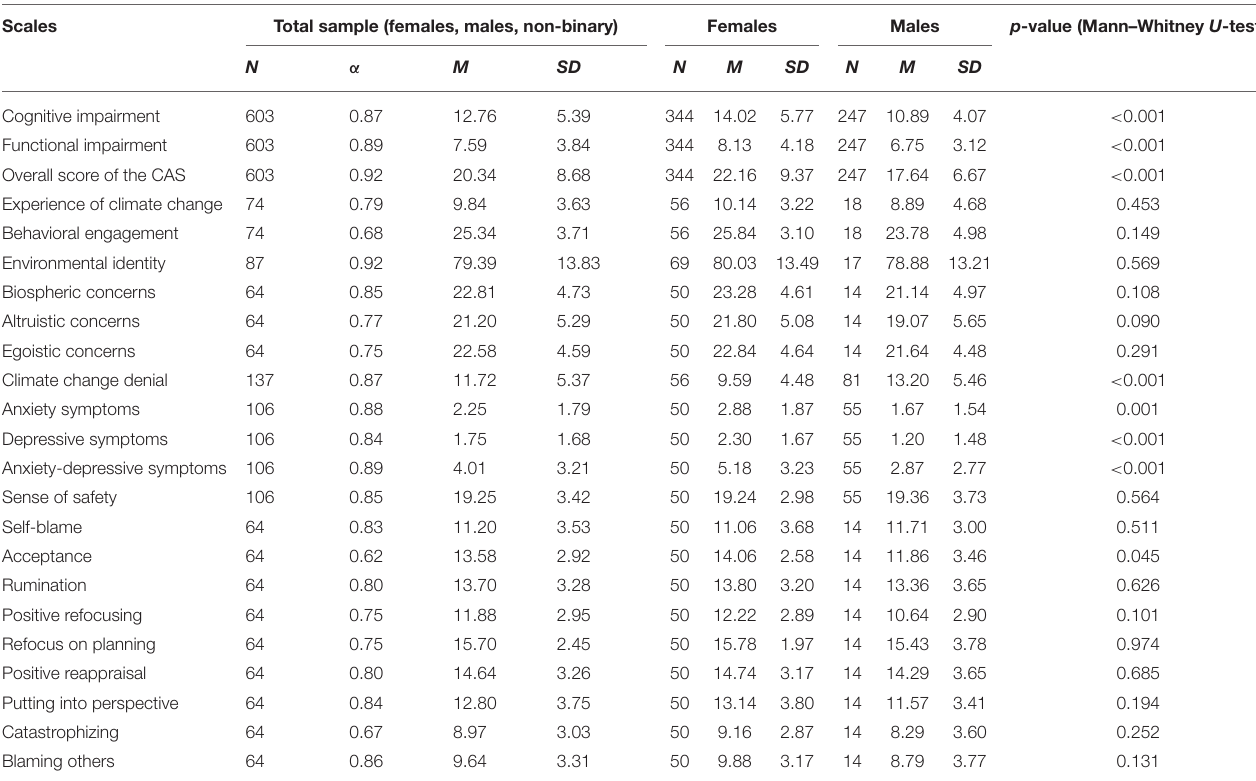
TABLE 1 | Descriptive statistics, Cronbach’s alpha ( α ) coefficients, and gender differences. Scales Total sample (females, males, non-binary) Females